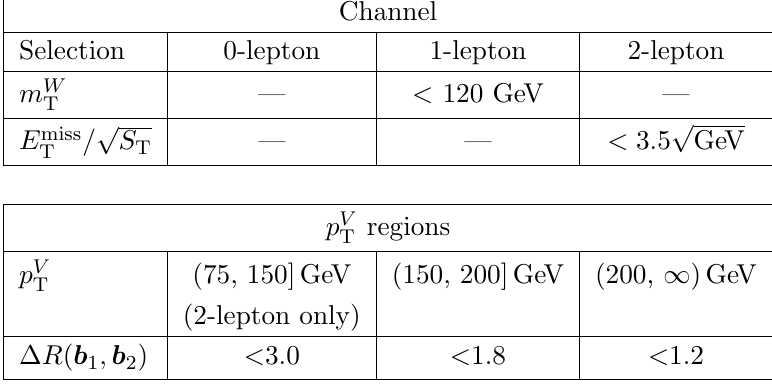
Table 4 . Summary of the event selection criteria in the 0-, 1- and 2-lepton channels for the dijet-mass analysis, applied in addition to those described in table 2 for the multivariate